Question: Briefly state, in one sentence, what is plotted here.
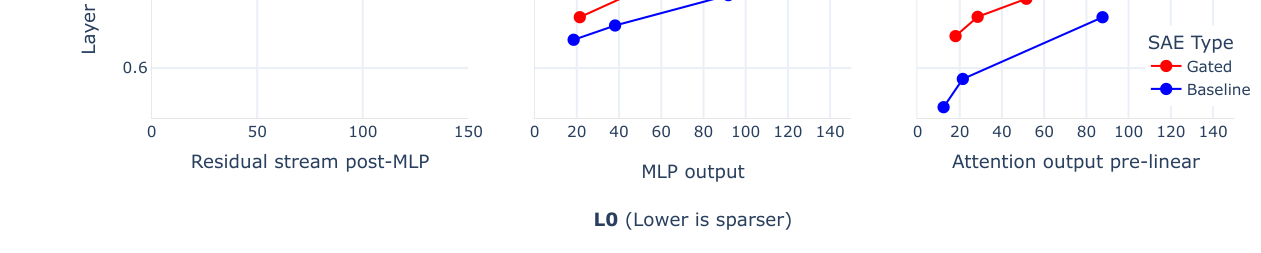
Answer: | Gated SAEs throughout Pythia-2.8B. At all sites we tested, Gated SAEs are a Pareto improvement. In every plot, the SAE with maximal loss recovered was a Gated SAE.